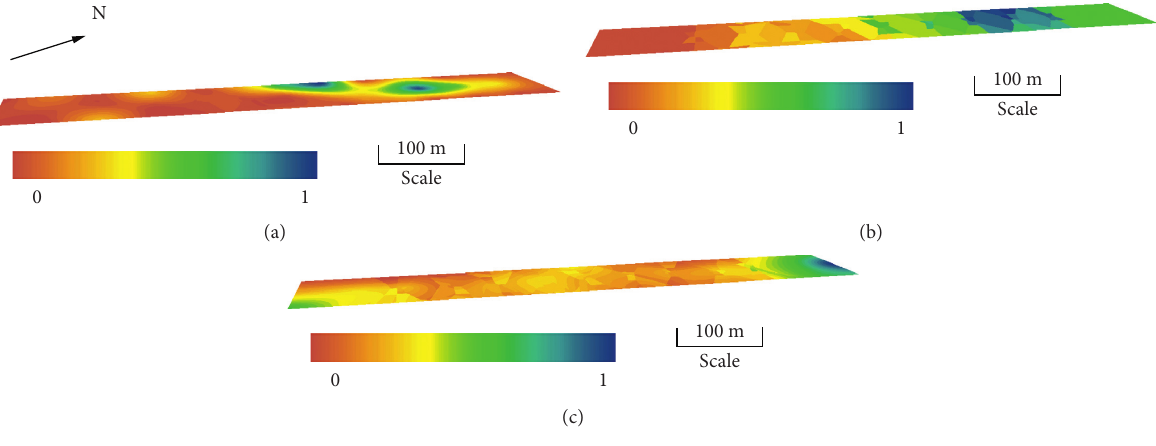
Figure 3: Spatial distribution characteristics of volume grout injected: (a) grouting volume of L 11 ; (b) grouting volume of L 10 ;(c) grouting volume of L 8 Table 3: Types of fissures filled with water.